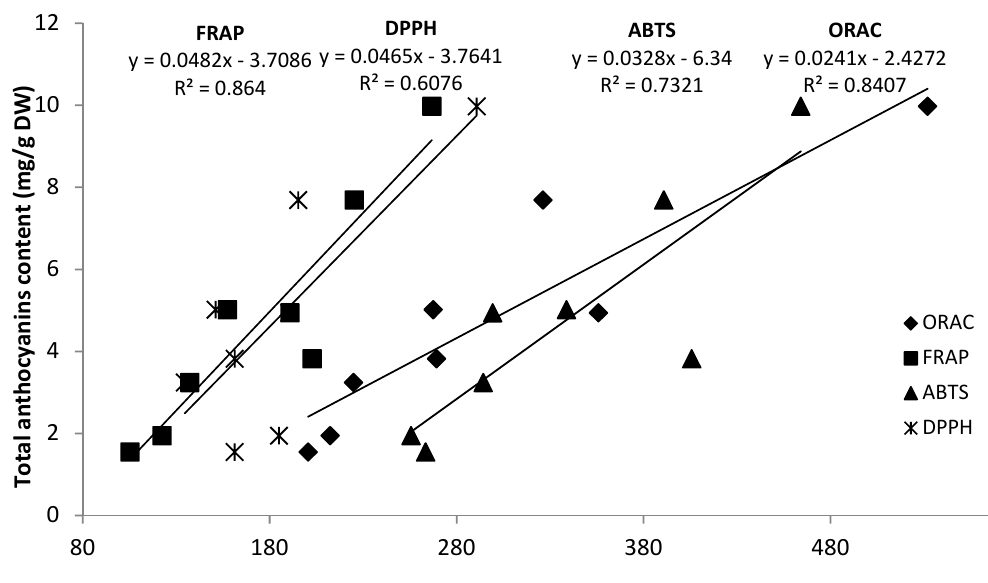
Figure 3. Correlations between radical scavenging capacity assays (ORAC, FRAP, ABTS and DPPH) and total anthocyanin content in grape pomace skins in